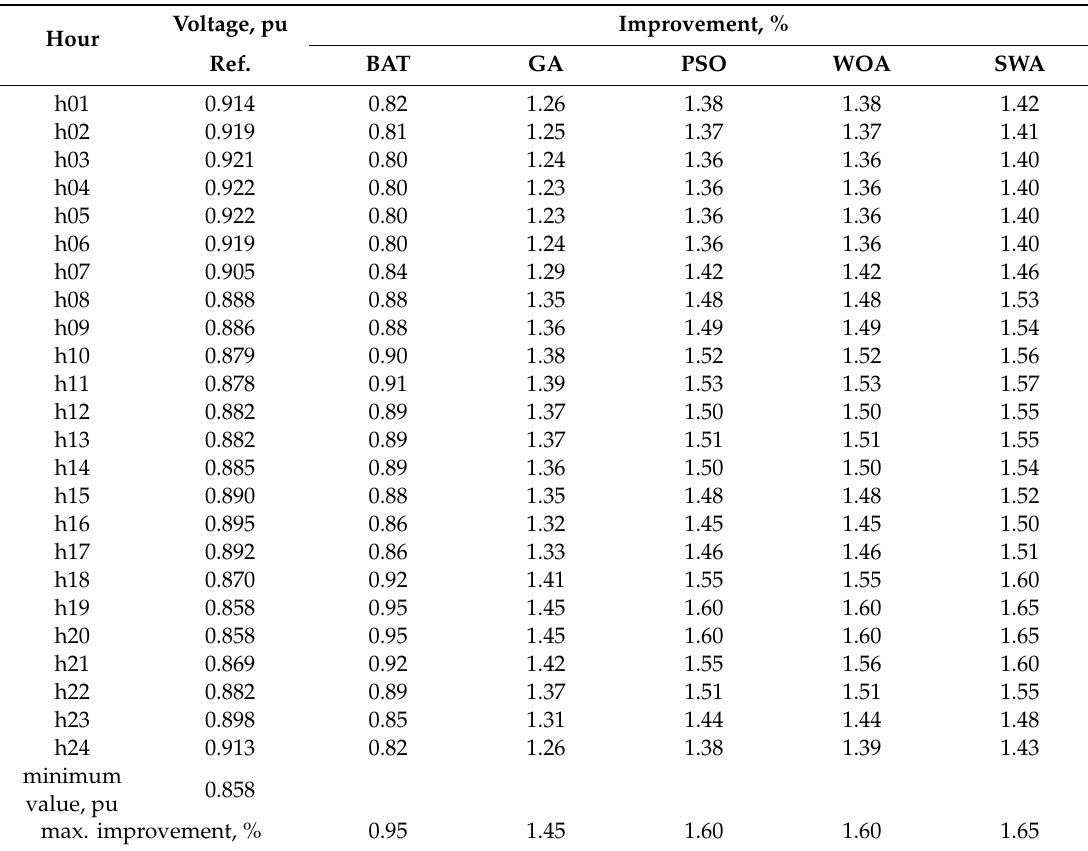
Figure 20. Voltage improvement after compensation for bus 33, the IEEE 33-bus system. Table 10. Hourly reference voltage values for bus 18 and percent improvements after compensation, the IEEE 33-bus test